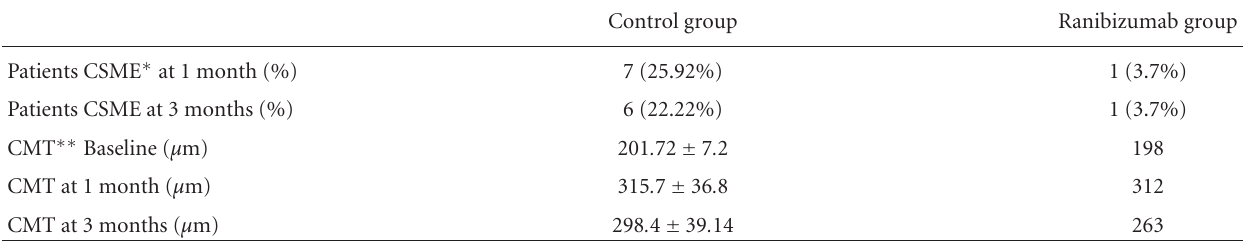
Table 2: Central-macular thickness at baseline compare to 1 and 3 months after the cataract surgery in both groups (including only patients that developed clinical significant macular edema ( ∗